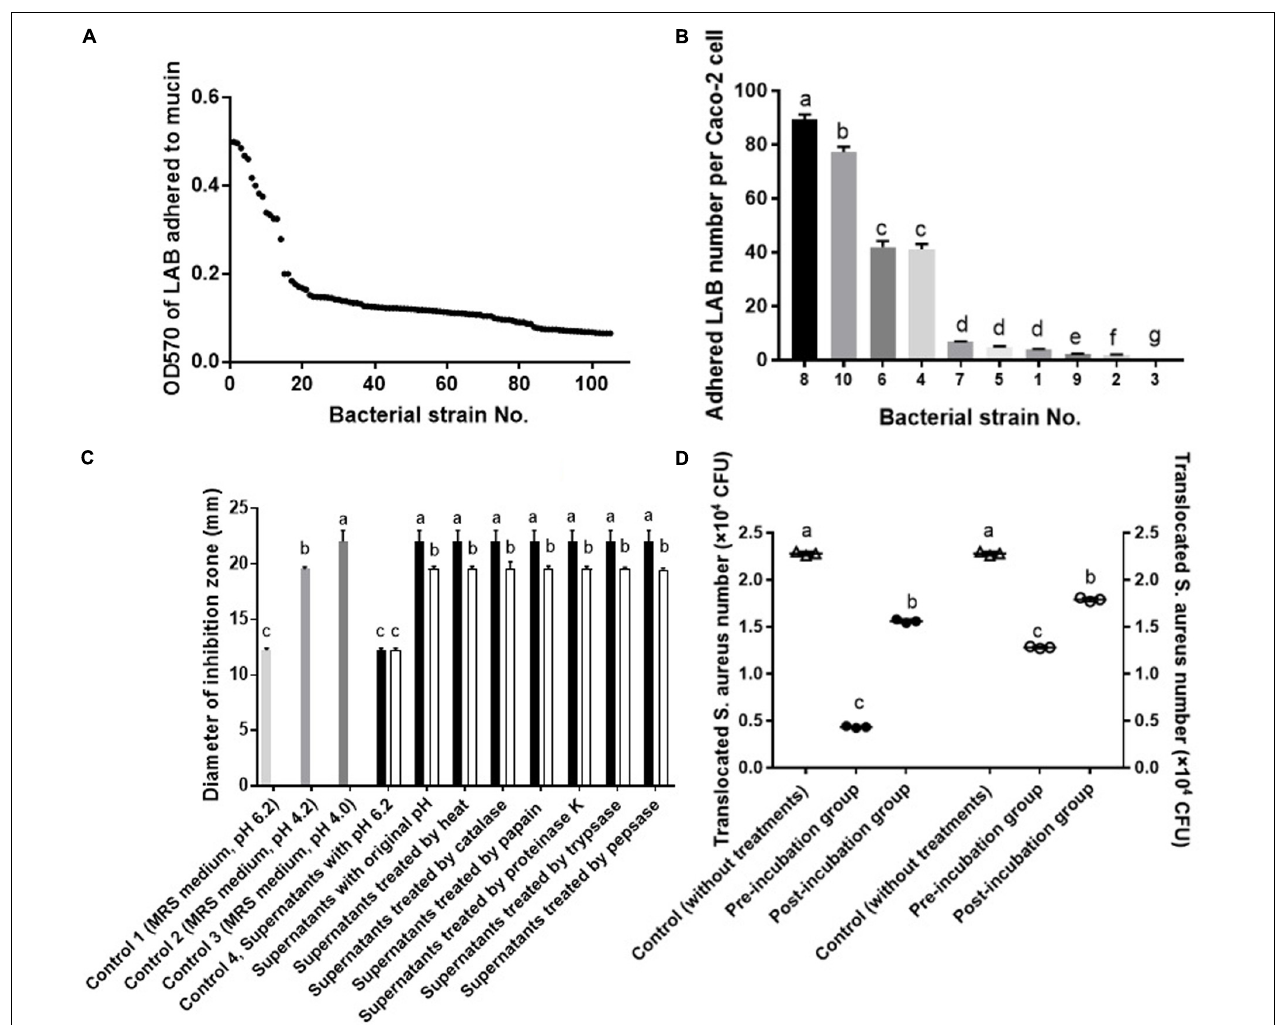
FIGURE 1 | Screening of LAB with strong affinity for mucin and Caco-2 cells inhibiting S. aureus growth and translocation. (A) Adhesion of LAB to mucin by microtiter assay. (B) Adhesion of LAB to Caco-2 cells by adhesion assay. (C) Inhibitory effect of LAB fermentation supernatants on the growth of S. aureus by well diffusion assay. (cid:4) supernatants of NCU3087, supernatants of NCU3088. (D) Inhibitory effect of LAB on the translocation of S. aureus by the transcellular translocation assay. (cid:77) Control (without treatment of lactobacilli), • treated with NCU3087, ◦ treated with NCU3088. The experiments were performed in triplicate and (cid:50) the data is mean ( ± SD) except for (A) . Different letters indicate statistically significant differences between